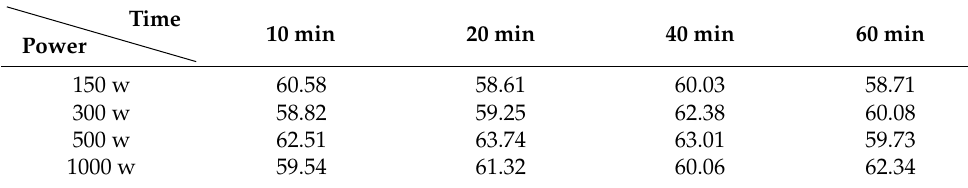
Table 2. Metallization rate table for different time and power values.